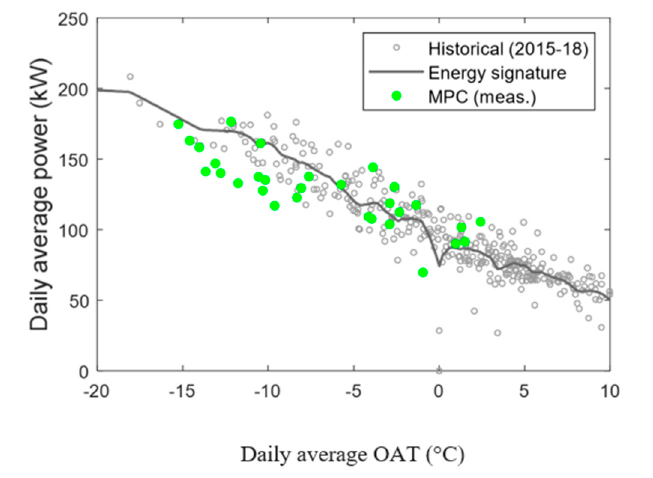
Figure 4. Daily average heating power demand: early results of the MPC implementation (winter